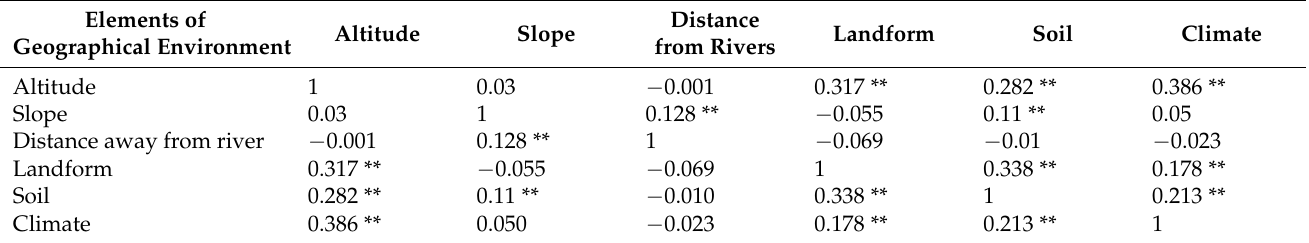
Table 7. Correlation coefficients between the geographic environmental